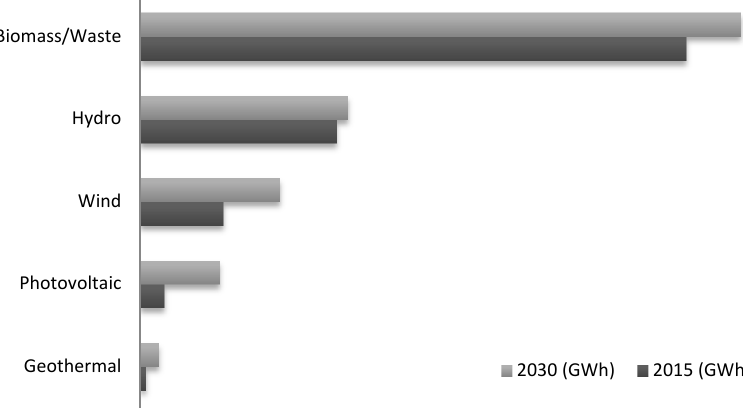
Figure 19. Renewable energy mix evolution between 2015 and 2030, Source: Own research based on ANRE data [20].